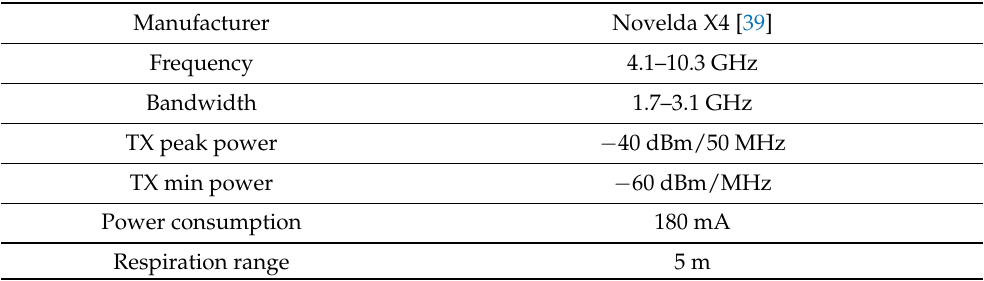
Table 2. Specifications of the UWB